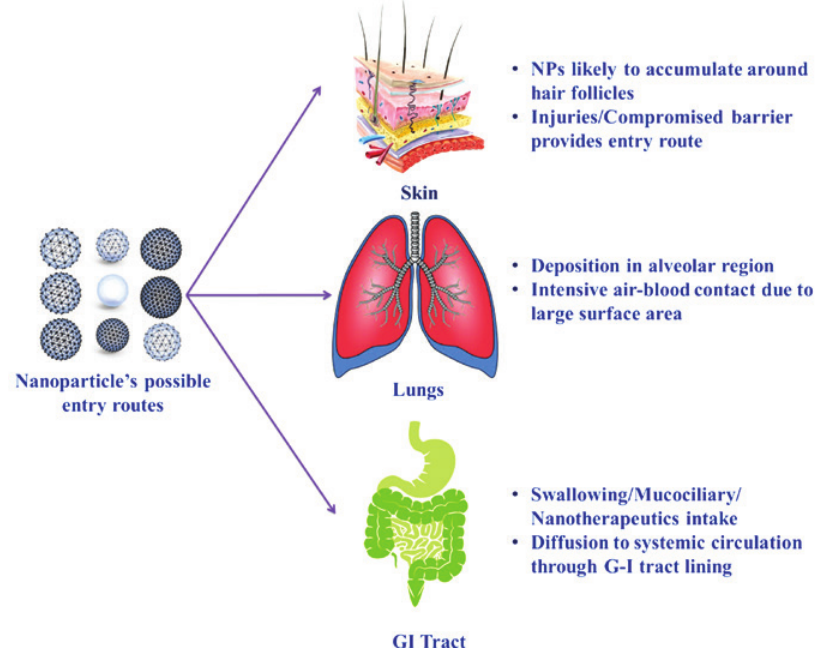
Figure 2: Possible routes of entry of a nanoparticle into the